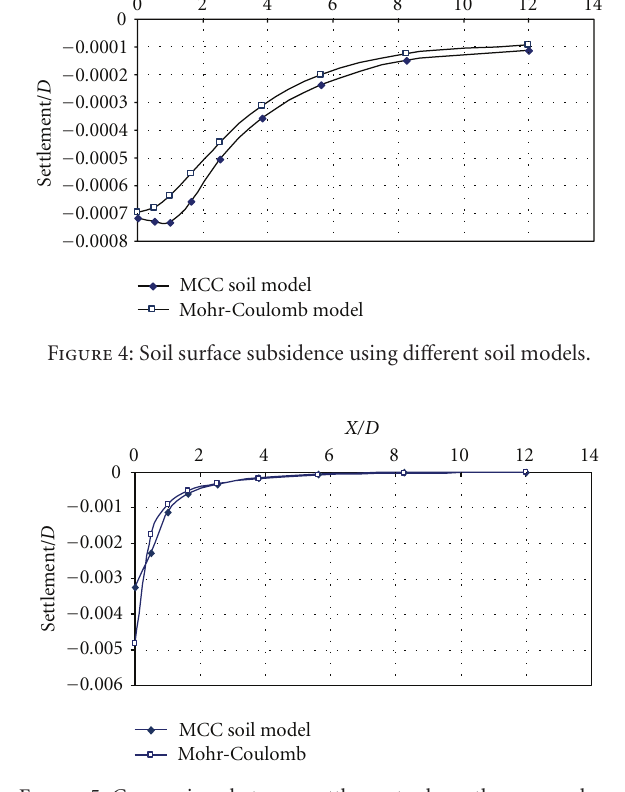
Figure 5: Comparison between settlements above the crown along section C-C using two soil models.